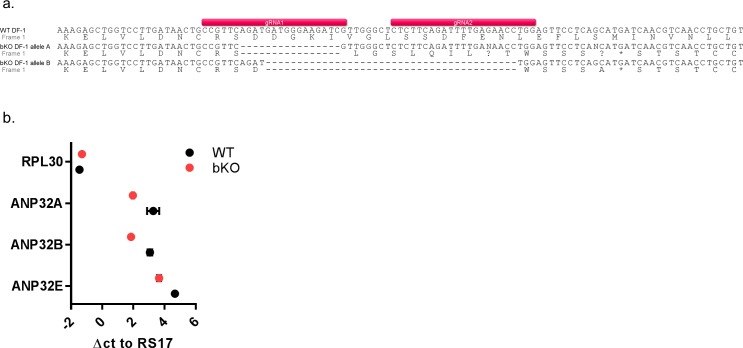
Sequence analysis of ANP32 in genome edited DF-1 chicken cells.(a) DNA sequence analysis of ANP32B from genomic DNA of DF-1 WT and ΔB clones, showing the target sequence of the gRNA pair used in the CRISPR/Cas9 reaction. Allele A had a 16 bp deletion and allele B a 40 bp deletion, resulting in premature stop codons in the ANP32B sequence. (b) qRT-PCR analysis of mRNA isolated from WT and bKO DF-1 cells. Data are Δct of RPL30, ANP32A, B or E to RS17. Data are Δct of RS17, ANP32A, B or E to RPL30. Annotated alignments generated using Geneious R6 software.